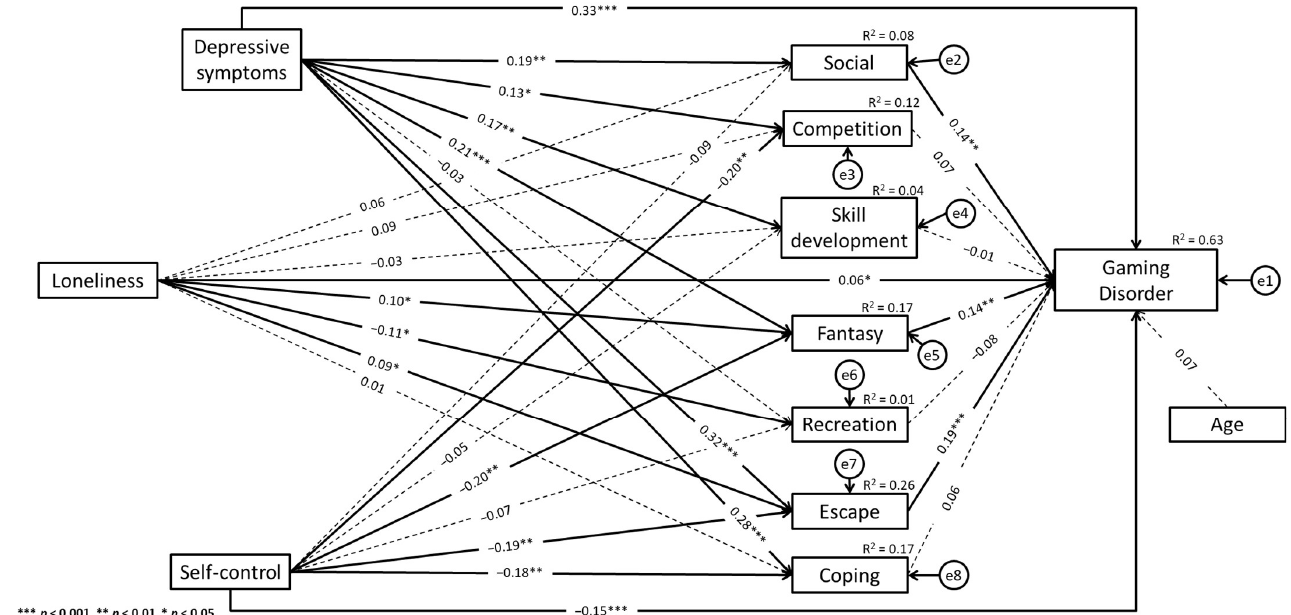
Figure 1. Paths model of the relationship between variables in male gamers group.